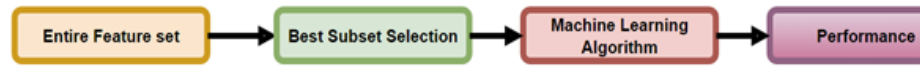
Figure 5. Process of the Feature Selection Filter Method Mehta et al.